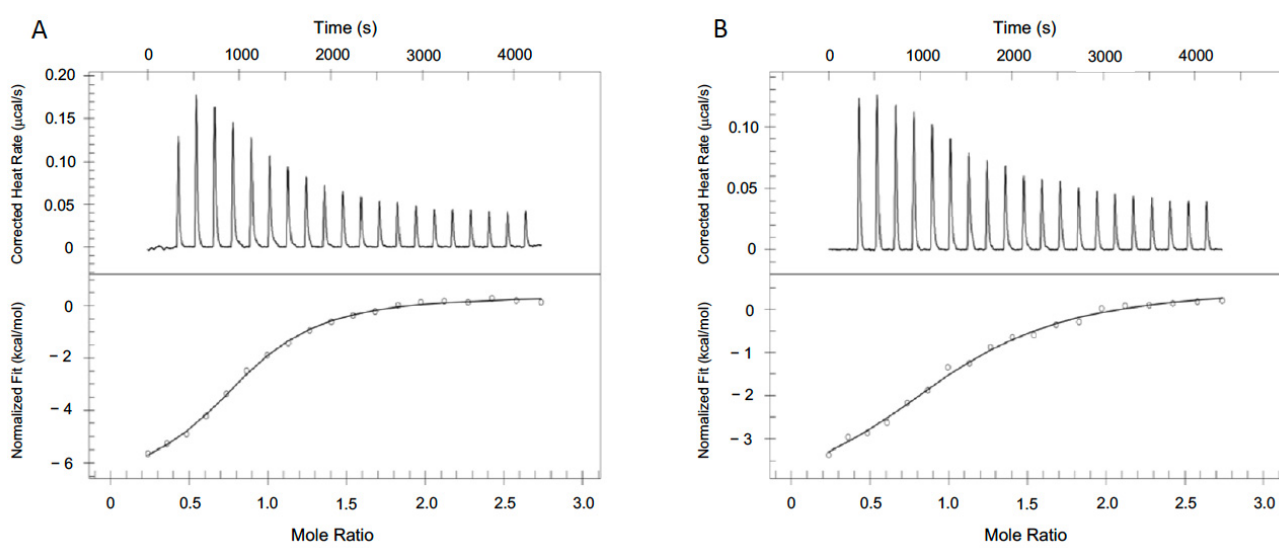
Figure 4. The measurements of the binding affinity of the cofactors to hMDH2. ( A ) Binding affinity measurement of NADH and hMDH2 by ITC. The upper panel shows the heat changes for injection of 2.5 μ L aliquots of 230 μ M NADH into 30 μ M hMDH2. The lower panel shows the integrated heats from the raw data. The data were fitted with an independent model. ( B ) Binding affinity measurement of NAD and hMDH2 by the competitive replacement method of ITC. The upper panel shows the heat changes for the injection of 2.5 μ L aliquots of 230 μ M NADH into 30 μ M hMDH2 pre-incubated with 600 μ M NAD. The lower panel shows the integrated heats from the raw data. The data were fitted with a competitive replacement model provided by TA Instruments. Table 2. Data collection and refinement statistics at 298.15 K.